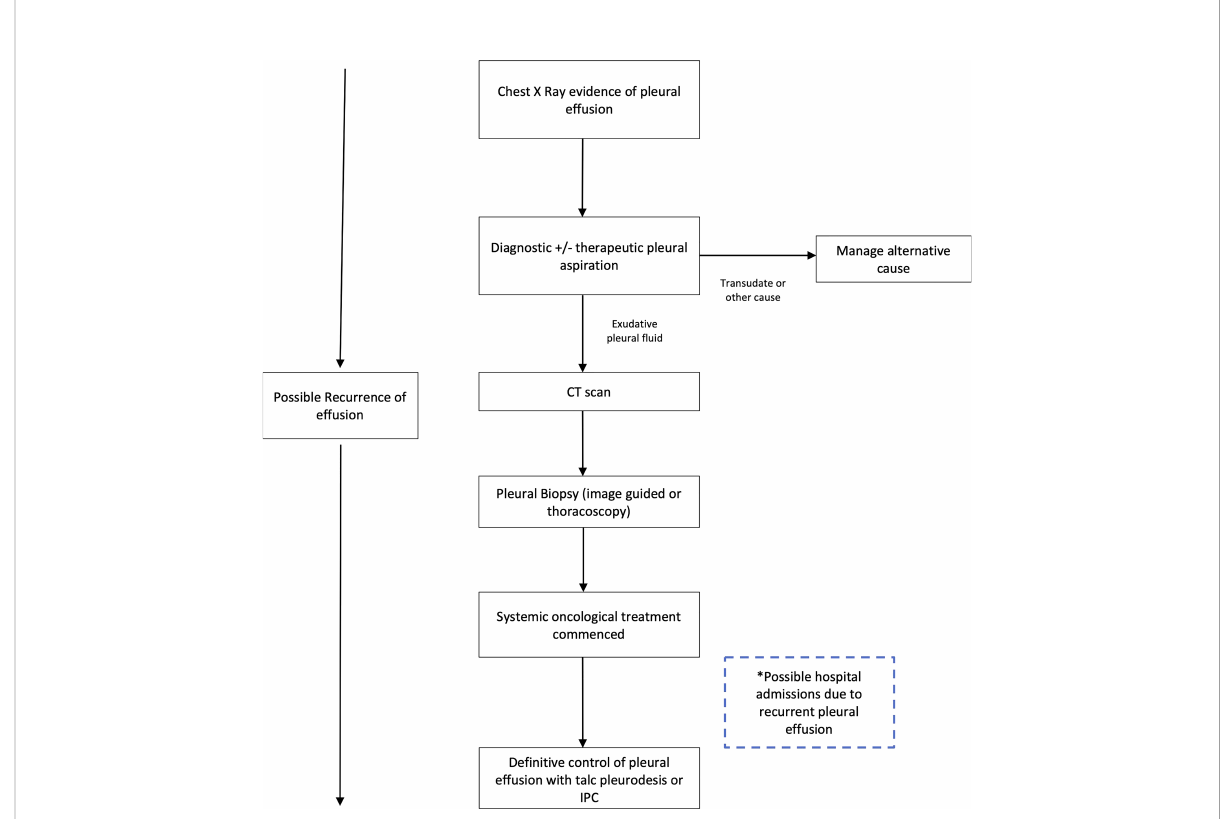
FIGURE 1 Current investigation and management pathway for diagnosis and management of malignant pleural effusion. Adapted from the British Thoracic Society Guidelines on management of pleural disease. CT, computed tomographic; IPC, Indwelling pleural catheter. De fi nitions: Transudate de fi ned by pleural fl uid with low protein and low lactate dehydrogenase (Light's